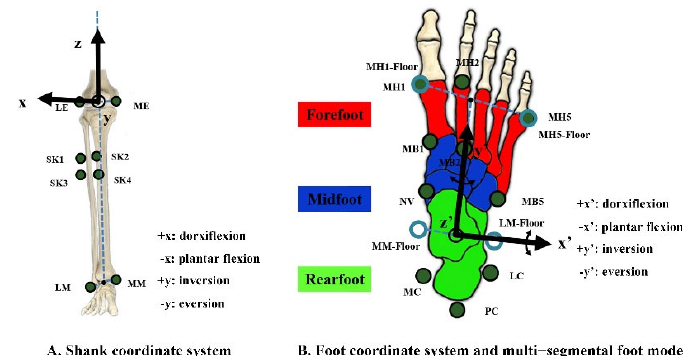
Table 1. Tracking markers for foot and shank